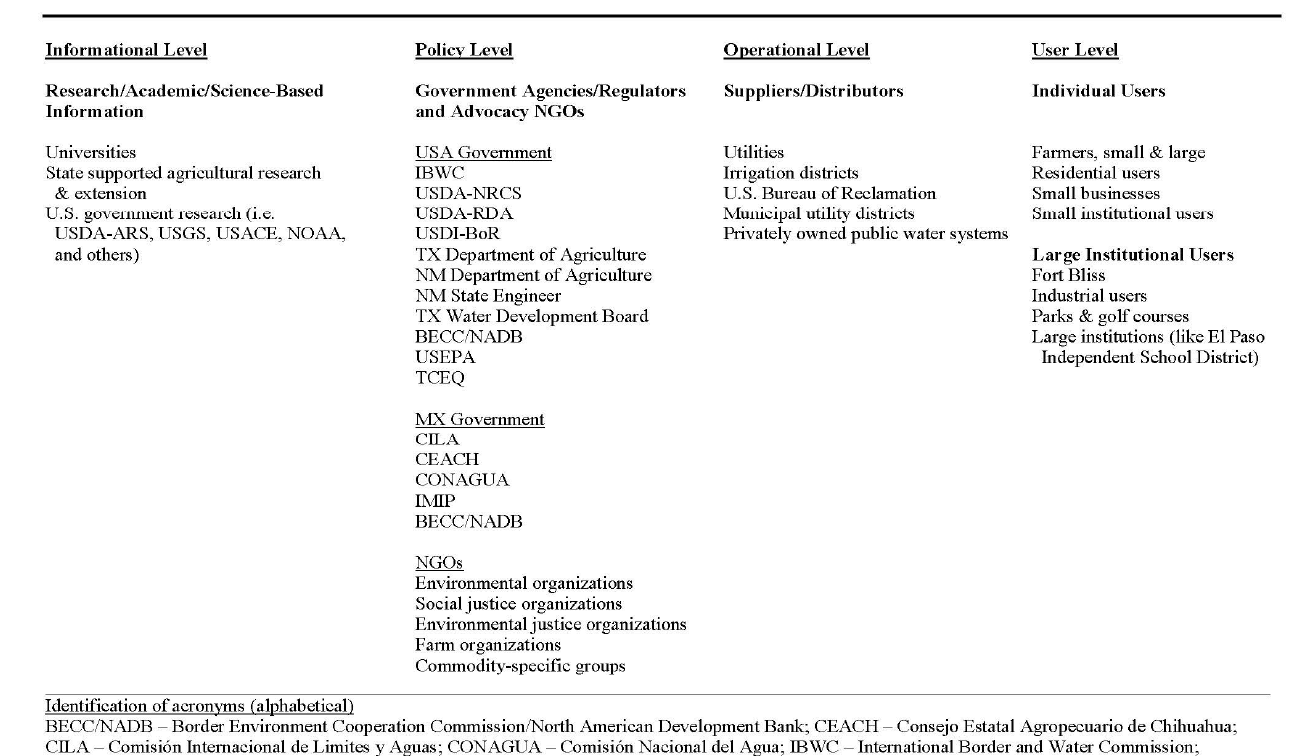
Figure 3. Identification of relevant stakeholders for each functional level.